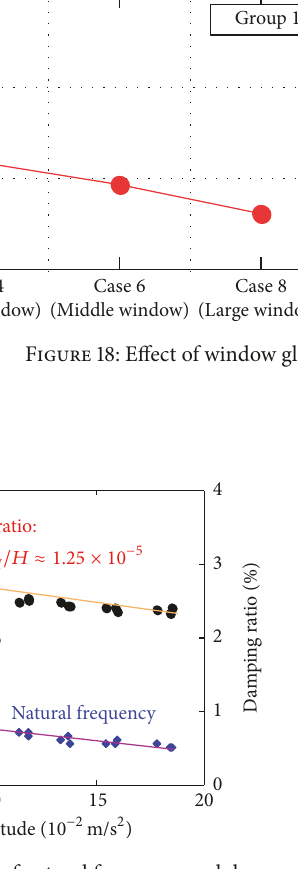
Figure 19: Amplitude dependency of natural frequency and damp- ing ratio of Case 3